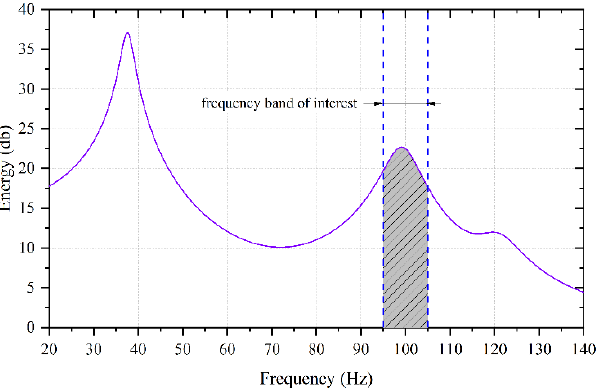
Figure 15. Energy frequency response of initial configuration calculated by FOM of PAF.